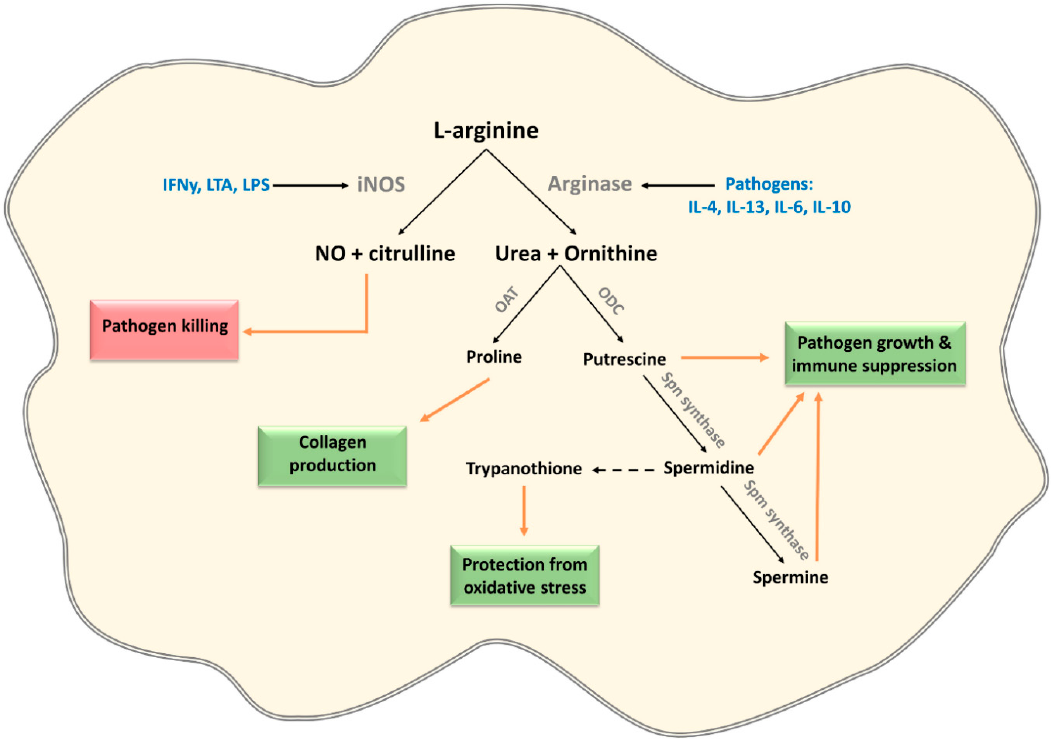
Figure 3. L-arginine is metabolized by iNOS and Arginase, creating competition between pathogen clearance and survival by modulating immune responses through the production of NO and polyamines. The dashed arrow represents a process only observed in trypanosomatid parasites.